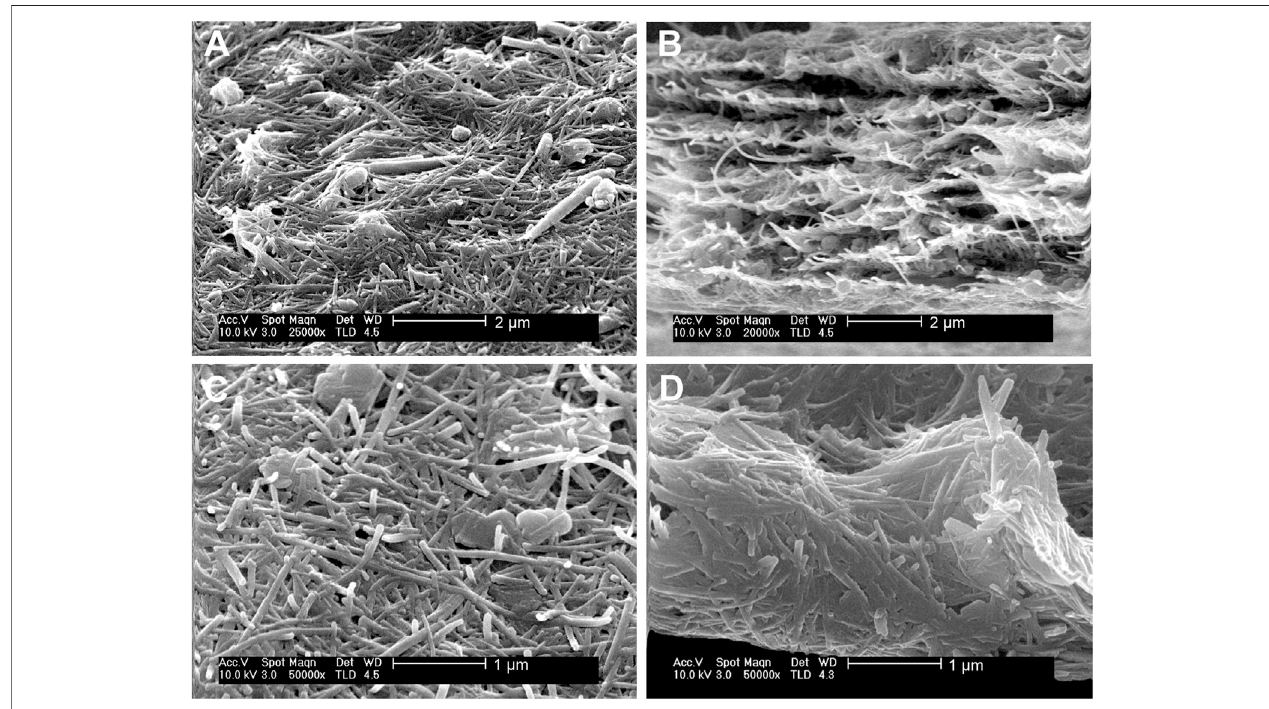
FIGURE 7 | SEM micrographs of HNT-SEP 1:1 (A) surface and (B) cross section, and of KAOL-SEP 1:2 (C) surface and (D) cross section.